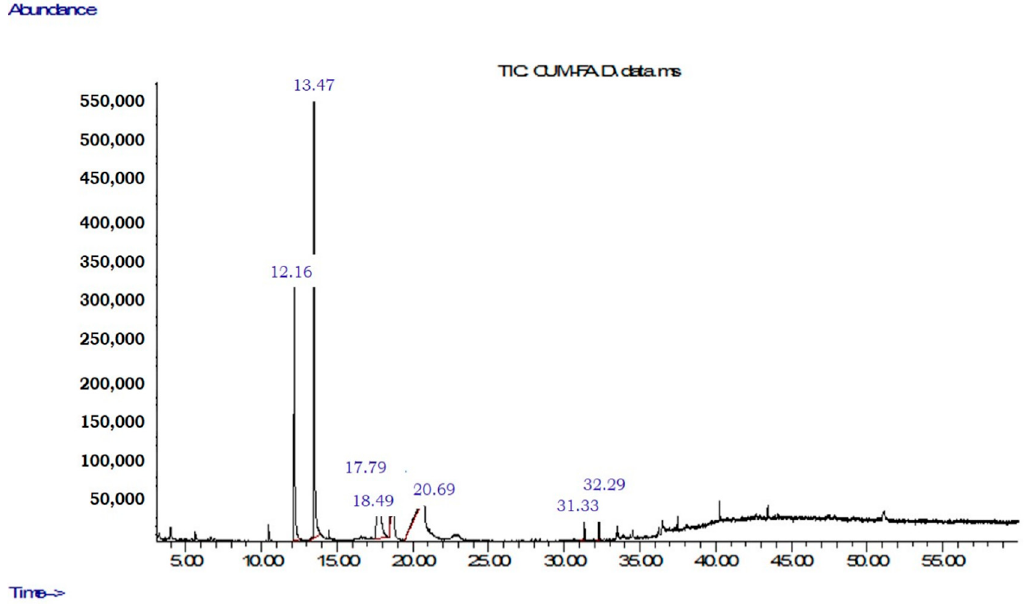
Figure A10. Dipteryx punctata seeds extract chromatogram .